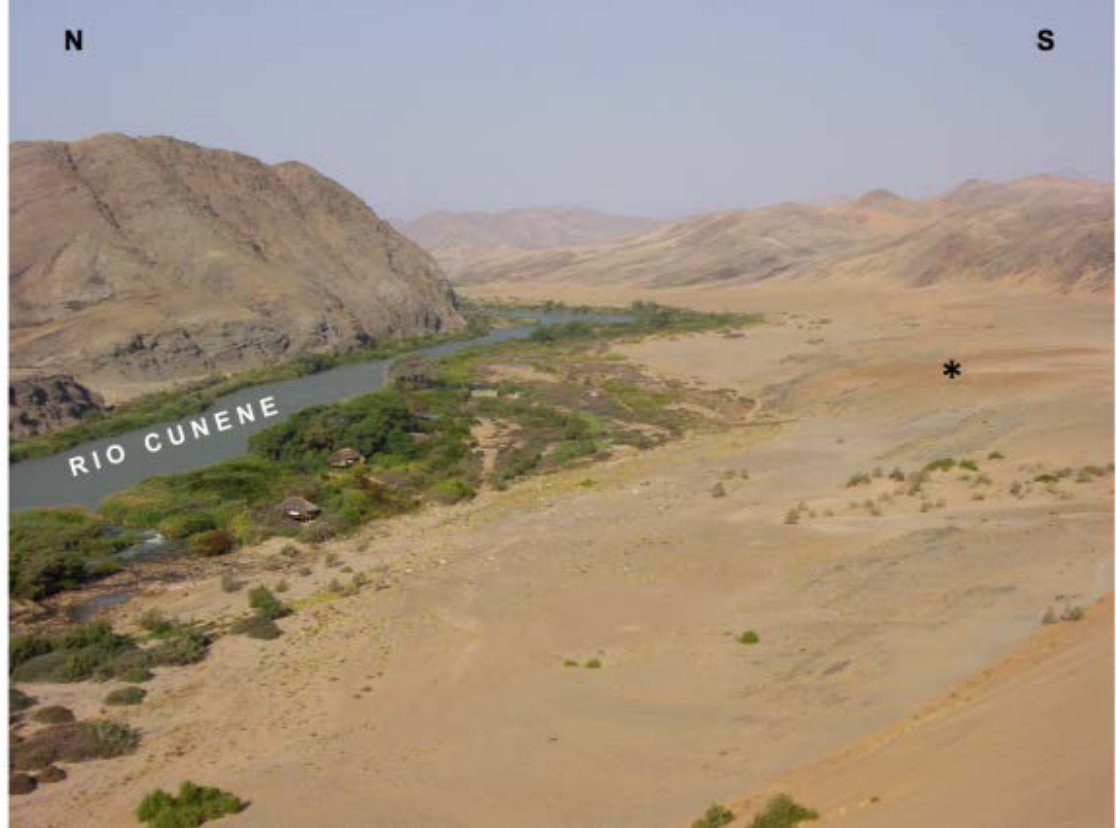
Figura 2. Visão geral da área de estudo de Cafema. A estrela indica a localização do terraço de Qal de cascalho de calhaus de quartzito ao longo da margem direita do Rio Cunene. A prospecção revelou a presença de 39 artefatos do PMA na superfície dentro da área de cascalhos no terraço do Rio Cunene. Figure 2. Overview of Cafema study area. Star denotes location of the relict quartzite cobble-gravel Qal terrace along the left bank of the Cunene River. Survey revealed the presence of 39 MSA artifacts at the surface, within the cobble-gravel